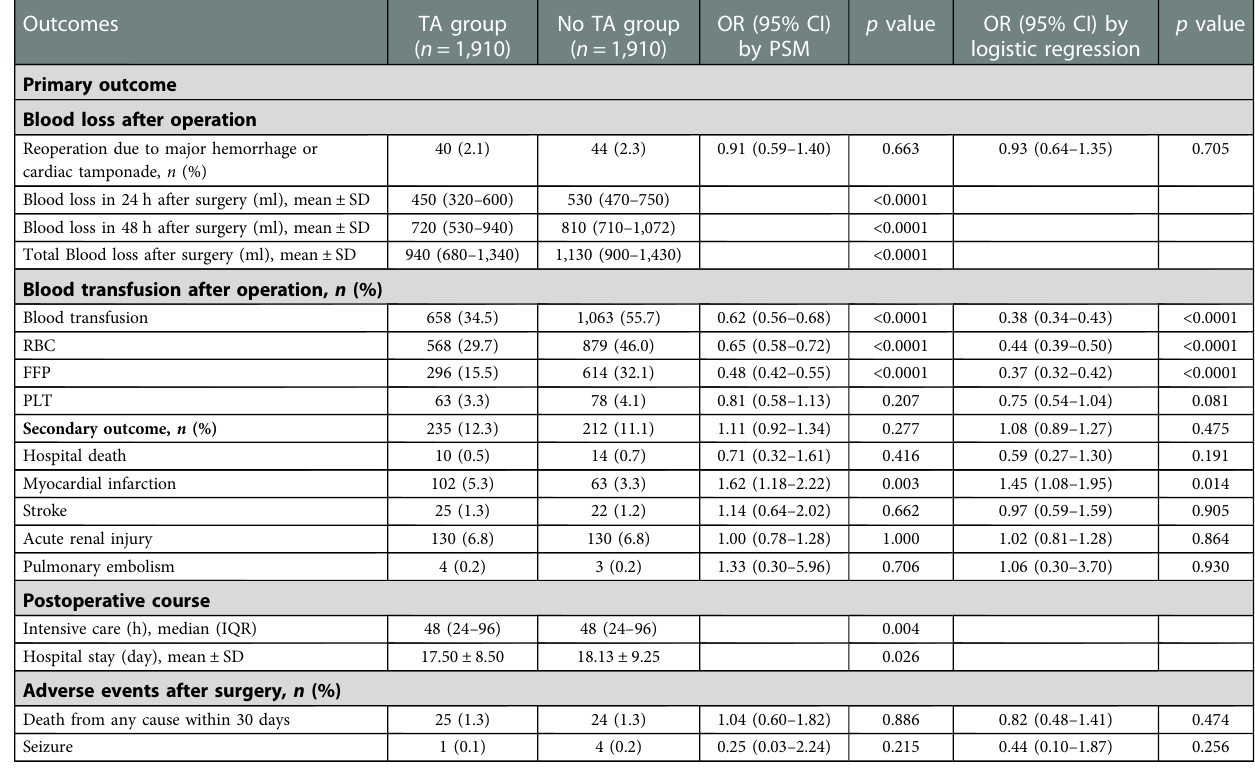
TABLE 3 Adjusted odds ratios in elderly patients for primary and secondary endpoints between the TA group and no TA group by PSM and logistic